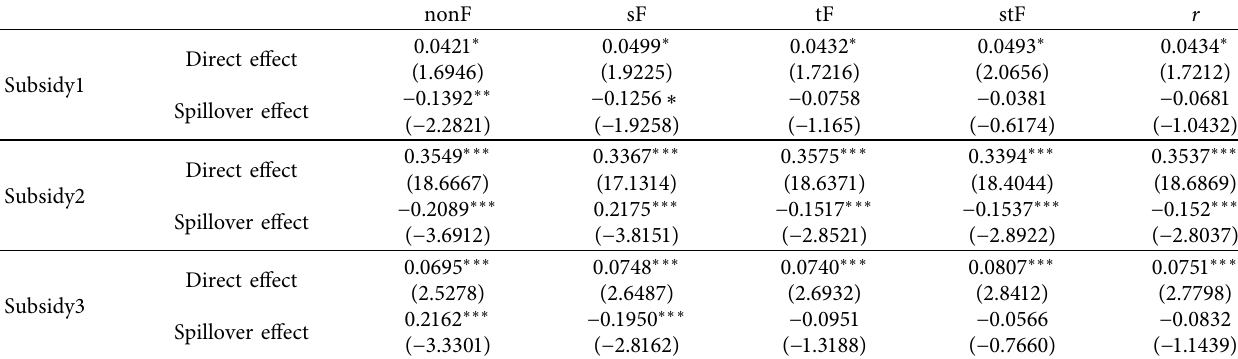
Table 7: Results of the impact mechanism test: impact on innovation